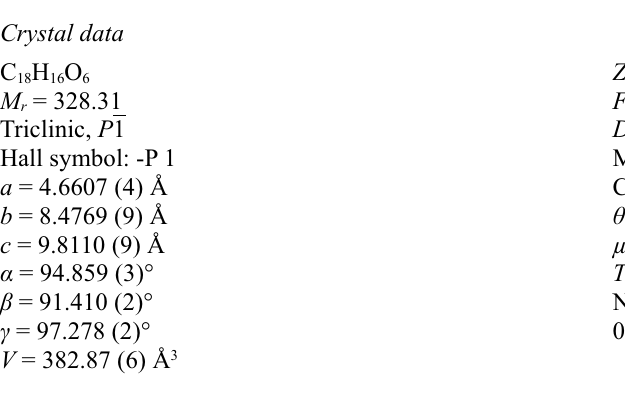
sup-2 Acta Cryst. (2012). E 68 , o2587